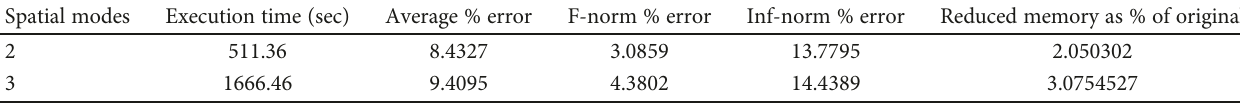
Table 12: Densities of 3D reduced model built from all 151 2D reduced models.